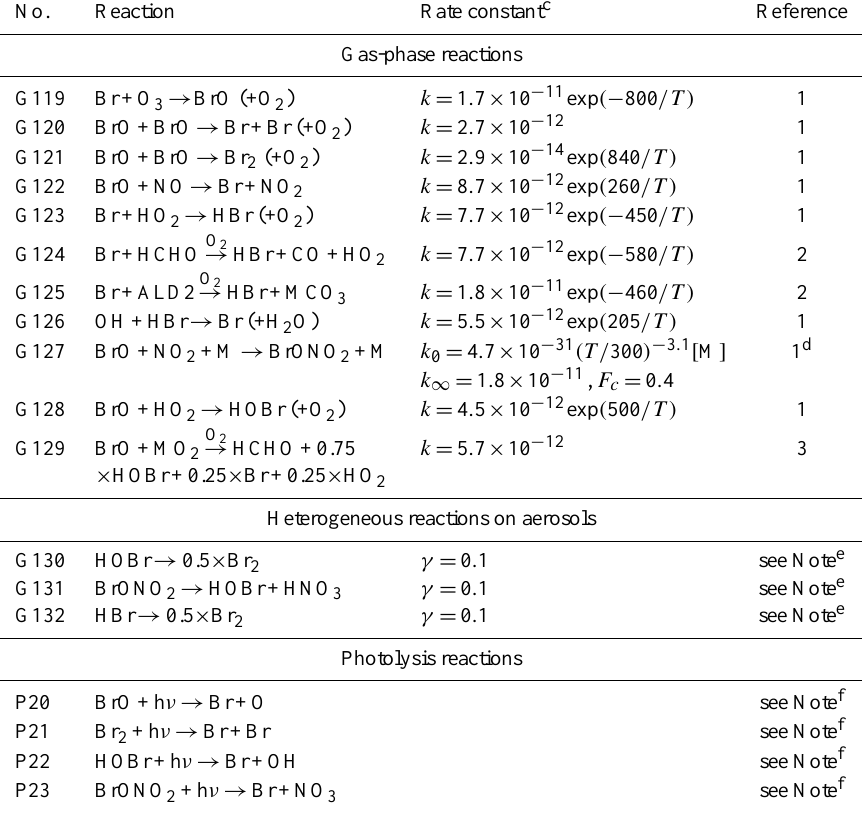
Table 1. Gas-phase, heterogeneous (on aerosols), and photolysis reactions of bromine species added to GEM-AQ for this study. a , b